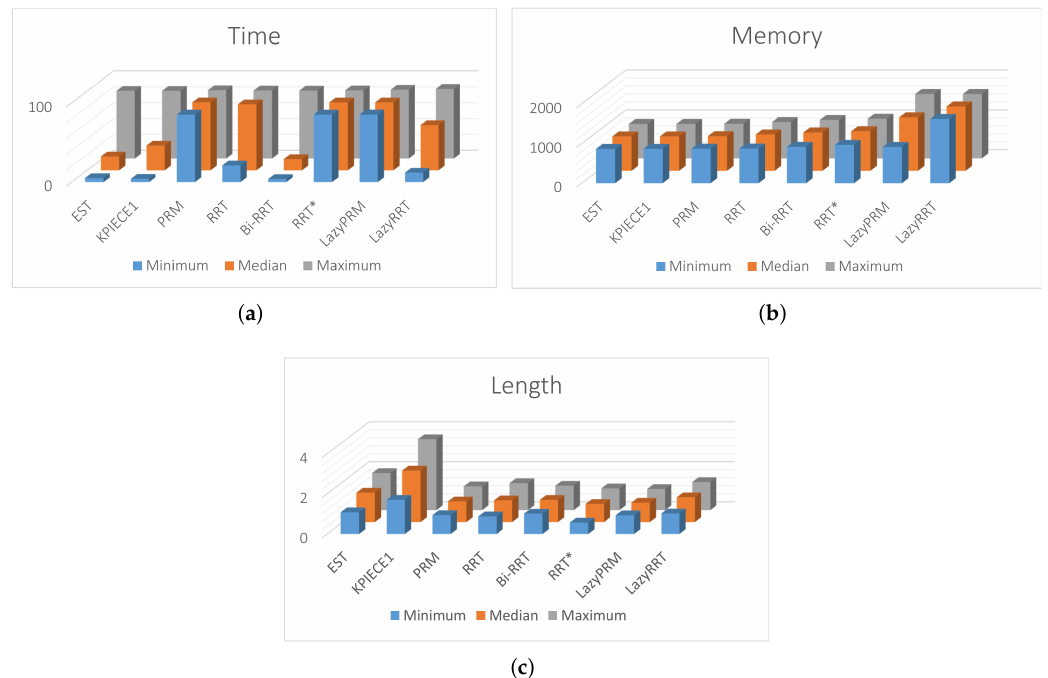
Figure 31. Bar graphs for time, length of path, and memory in number of times respect to the MGHPPM results of case 2. ( a ) Execution time. ( b ) Memory. ( c ) Length of